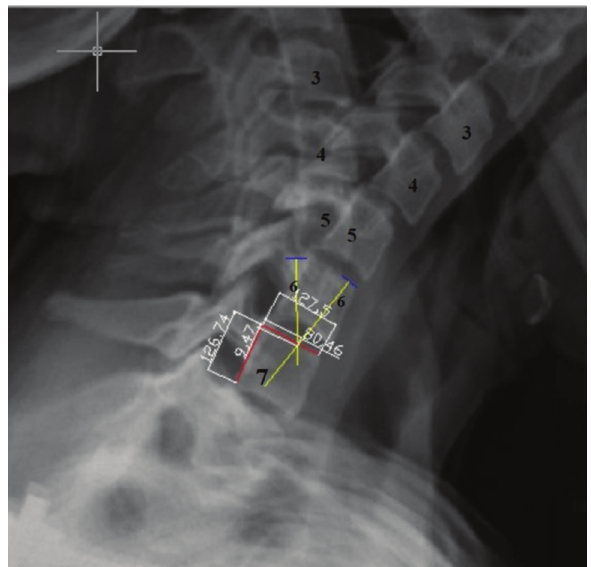
Fig. 3: The ICR in segment C6-7. The yellow lines indicate the vertices drawn from the midpoints of the four points on the anterior and posterior corner of the C6 vertebrae in the overlapped flexion and extension film, the red lines indicate the superior (x-axis) and posterior (y-axis) walls of the C7 vertebra, and the white lines indicates the perpendicular lines from the ICR centre to the x and y- axis. The coordinates of ICR in x-axis and y-axis was normalised to each vertebral border height. In this example x coordinate was 0.63(80.46/127.5), and y coordinate was 0,074 (9.47/126.74).